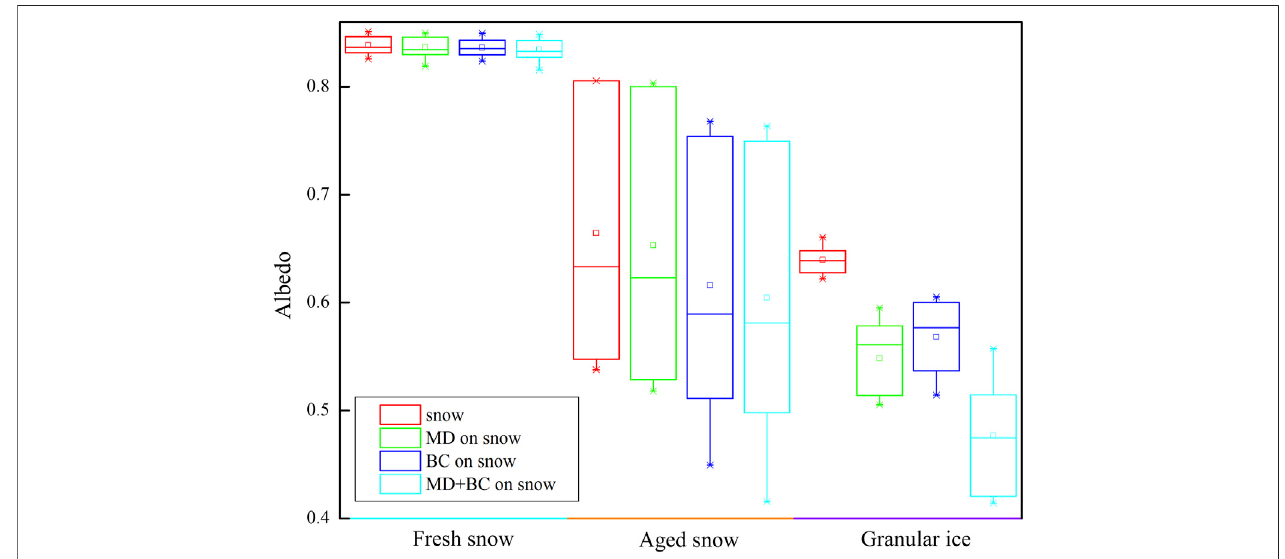
FIGURE 8 | The reduction of albedo by BC and MD on Urumqi Glacier No.1 under three different melting conditions: fresh snow, aged snow, and granular ice.